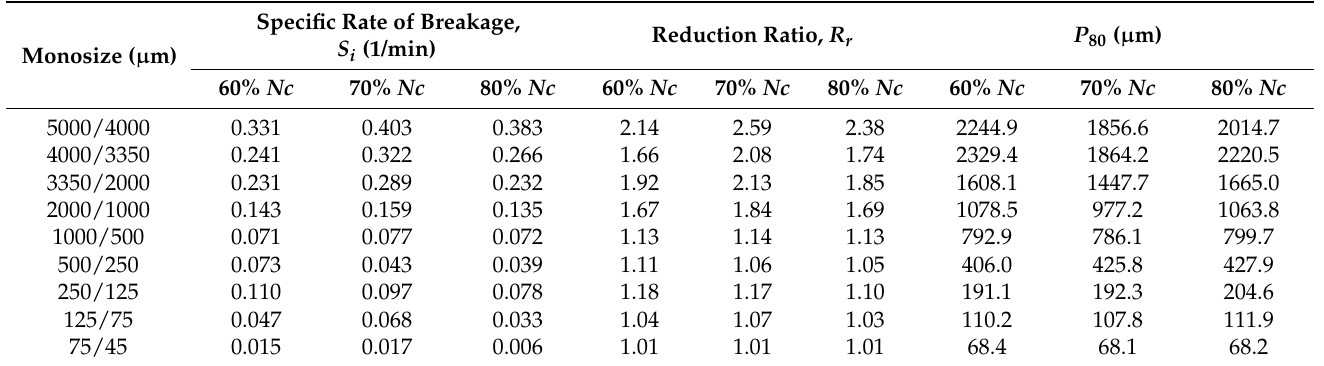
Table 3. S i , R r , and P 80 values as a function of working speed for each monosize.